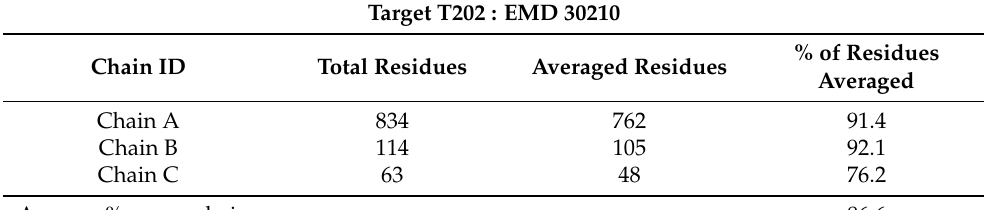
Table 2. Number of residues averaged for target T202: EMD 30210.